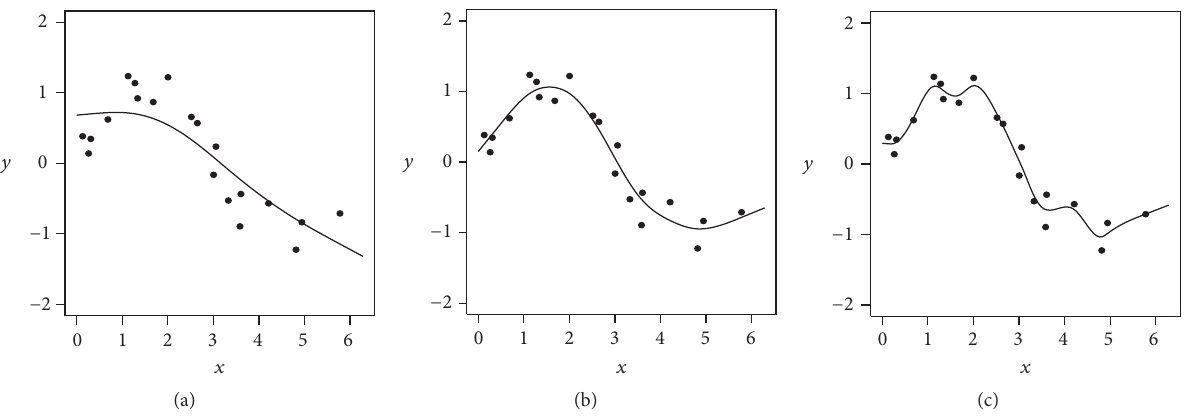
Figure 1: Smoothing spline fits to sin data: (a) Df = 3 ; (b) ̂ Df = 5.5 ; (c) Df = 11 .